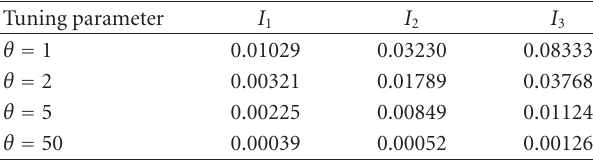
Table 2: Performance criterion results (free-noise data). Tuning parameter